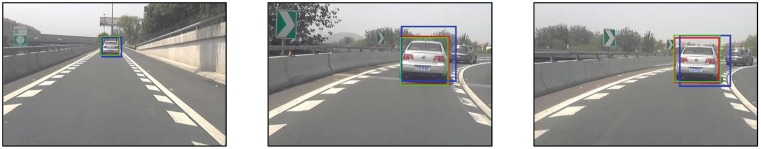
Video sequence of single vehicle with large scale change.Blue-KF, green-GT, red-ours.